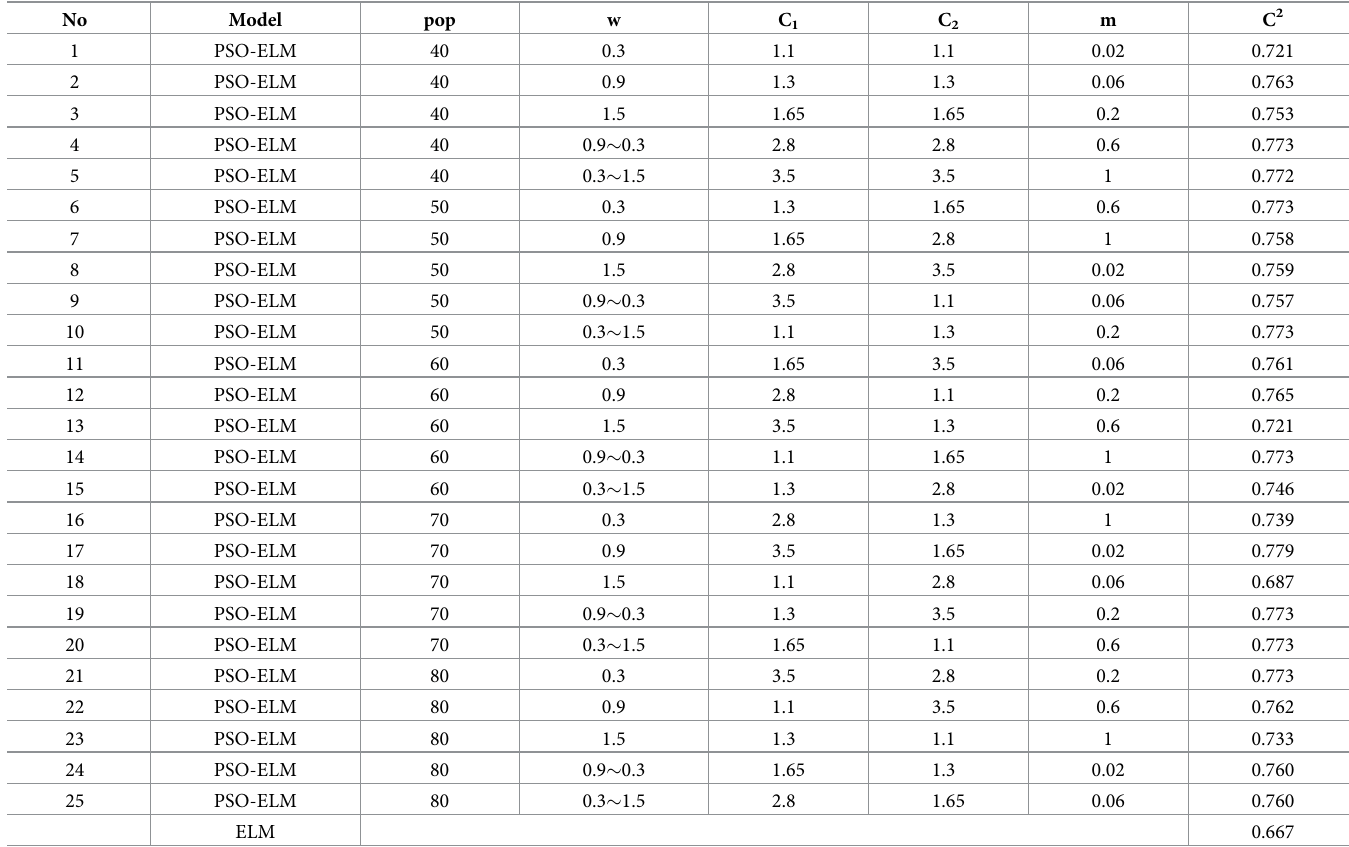
Table 2. Orthogonal array test for PSO-ELM.